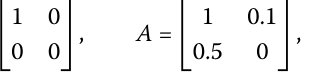
Figure 2 The tracking performance of the system output y (2) different iterations by using the learning algorithm (2).